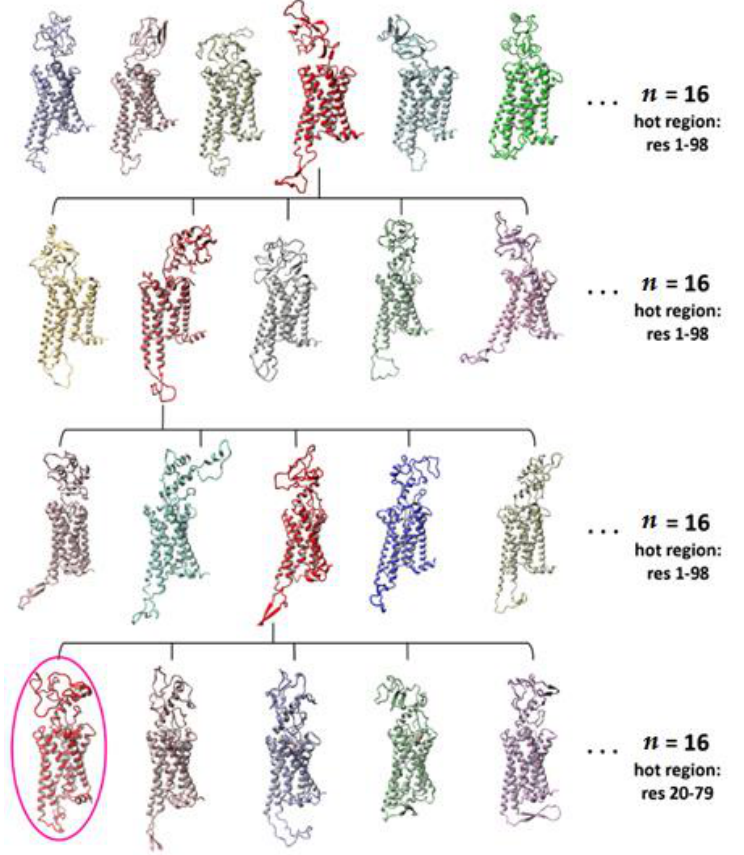
Figure 15. Sample structures of CB 1 receptor with complete N-terminal domain at each selection step of the REST2 MD simulations. The span of hot region of N-terminal domain and number of replicas in each step are specified on the right.